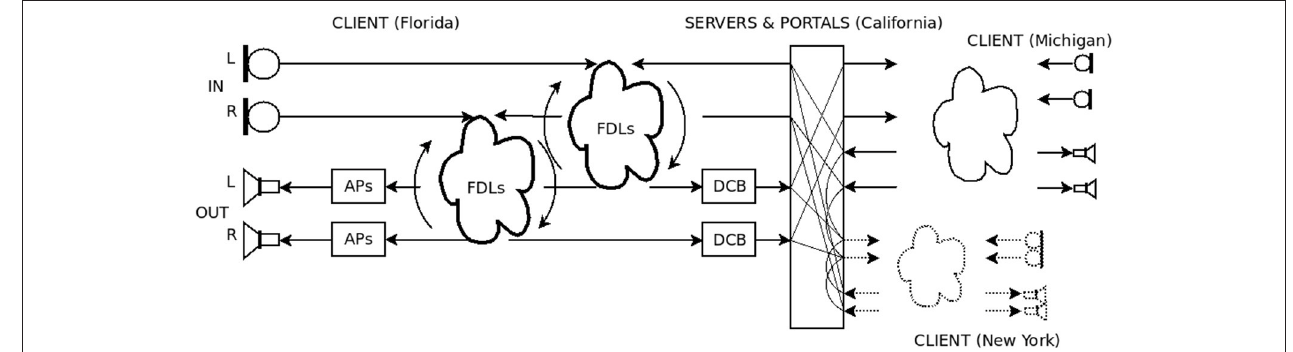
FIGURE 8 | A 3-room WAIR system with hub in CA and clients in FL, MI, and